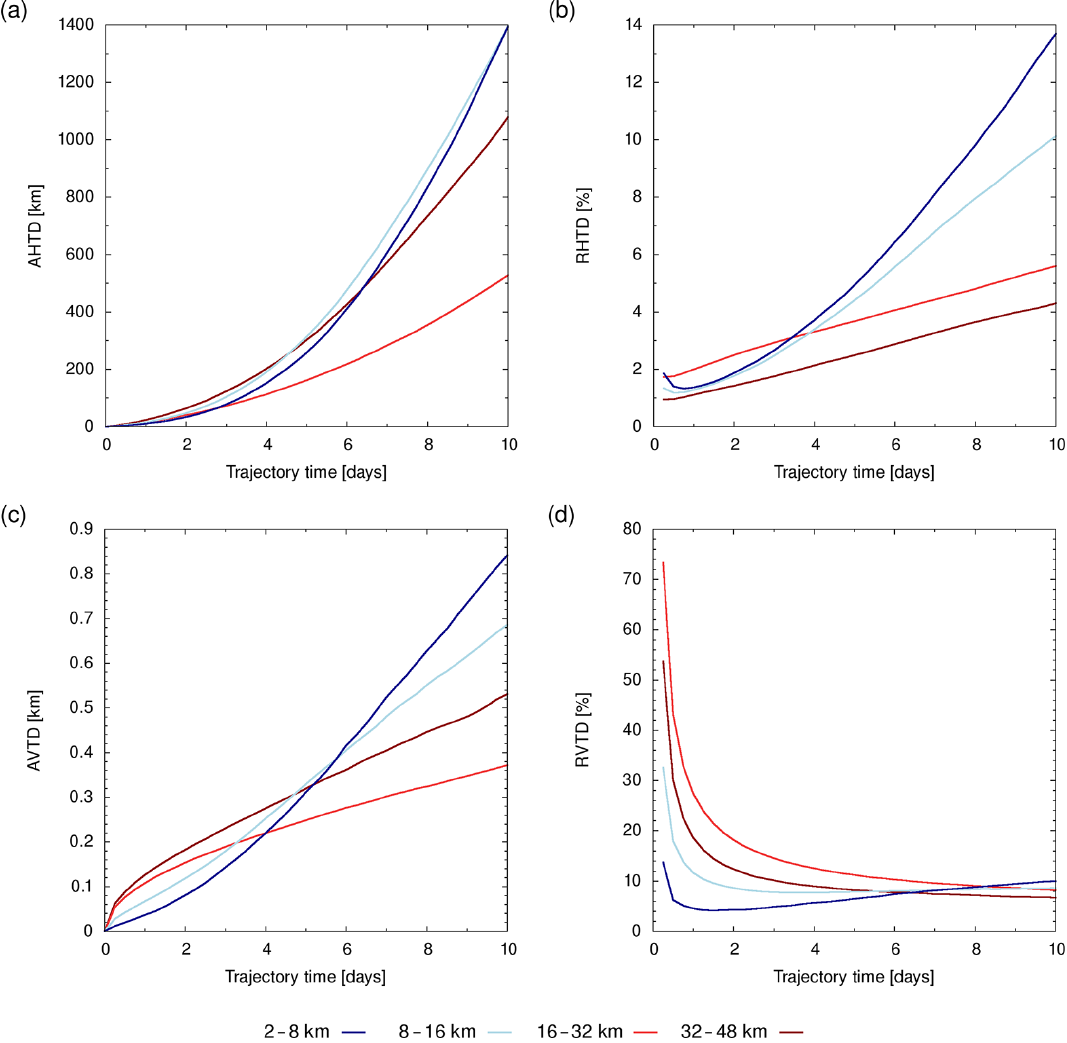
Figure 6. Global horizontal (a, b) and vertical (c, d) transport deviations of 10-day forward trajectories due to parameterized diffusion and subgrid-scale wind fluctuations. All trajectories were launched on 1 July 2017, 00:00UTC and calculated with the MPTRAC model driven by ERA5 data. The color coding refers to different altitude